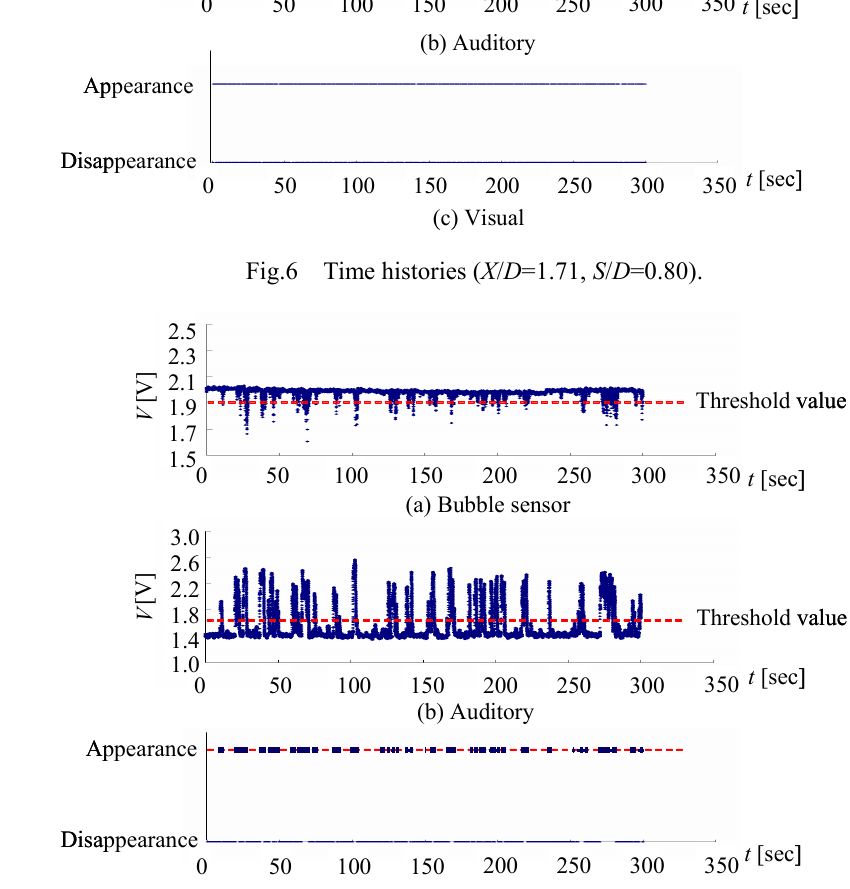
Time histories ( X / D =1.71, S / D